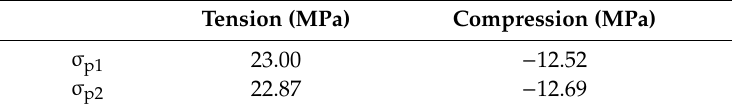
Table 1. Principal stresses computed for the deformed